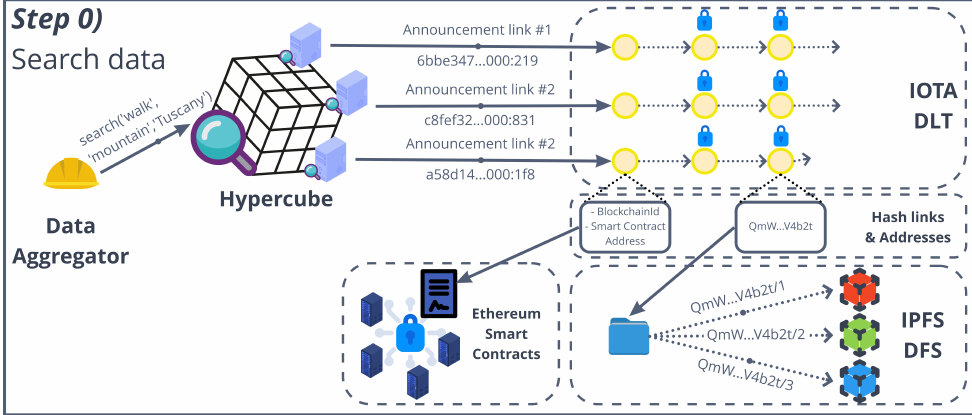
Figure 4. Example of searching data on the decentralized marketplace.